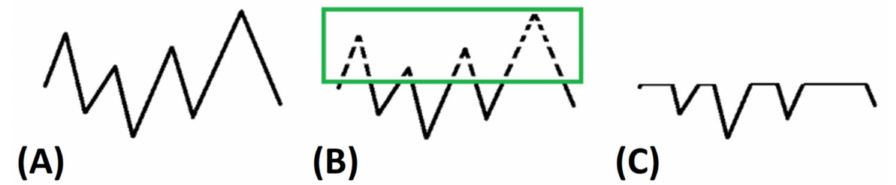
Figure 2. Profiles of a plateau honed surface: ( A ) after first rough honing step, ( B ) peaks to be removed in the final honing step (in green), ( C ) after final plateau step.